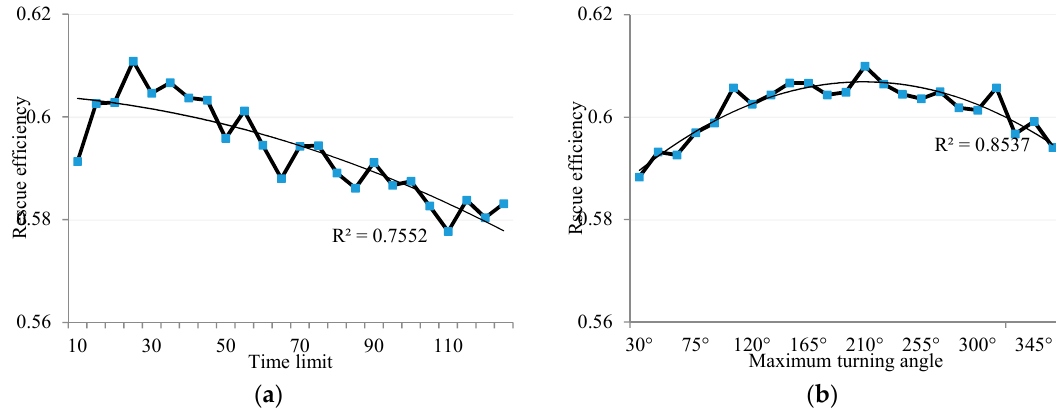
Figure 9. Sensitivity analysis of cooperative rescue plan. ( a ) Relation between the time limit for rescuing one site and rescue efficiency; ( b ) Relation between the maximum turning angle and rescue efficiency.